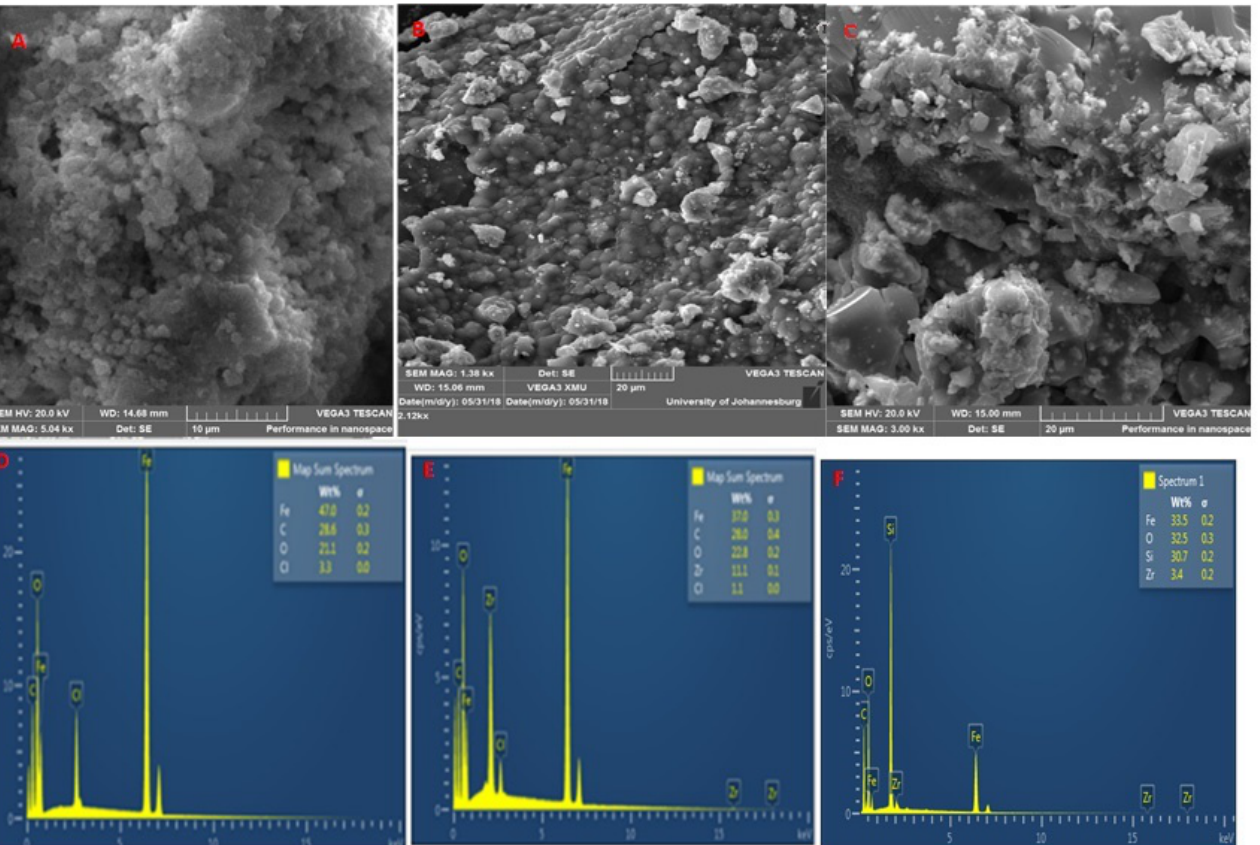
Figure 3. SEM images of ( A ) Fe 3 O 4 nanoparticles, ( B ) Fe 3 O 4 -ZrO 2 and ( C ) Fe 3 O 4 -ZrO 2 @APS nanocomposites and EDX spectra of ( D ) Fe 3 O 4 nanoparticles, ( E ) Fe 3 O 4 -ZrO 2 and ( F ) Fe 3 O 4 -ZrO 2 @APS nanocomposites.